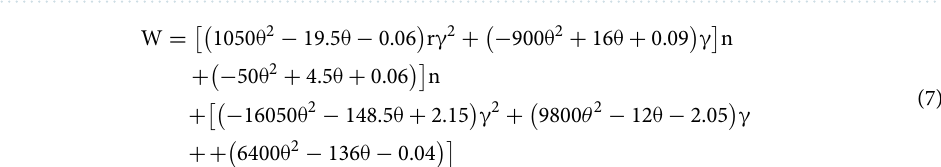
Figure 11. Flexural strength of specimen: ( a ) steel fiber content 0%; ( b ) steel fiber content 1%; ( c ) steel fiber content